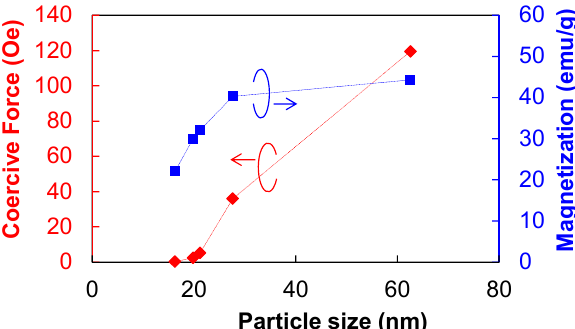
Figure 6. Magnetization curves of the Ni nanoparticles, entire ( left ) and enlarged views ( right ), at the TOP/Ni ratios of ( a ) 0, ( b ) 0.1, ( c ) 0.3, ( d ) 0.5, and ( e ) 0.8.